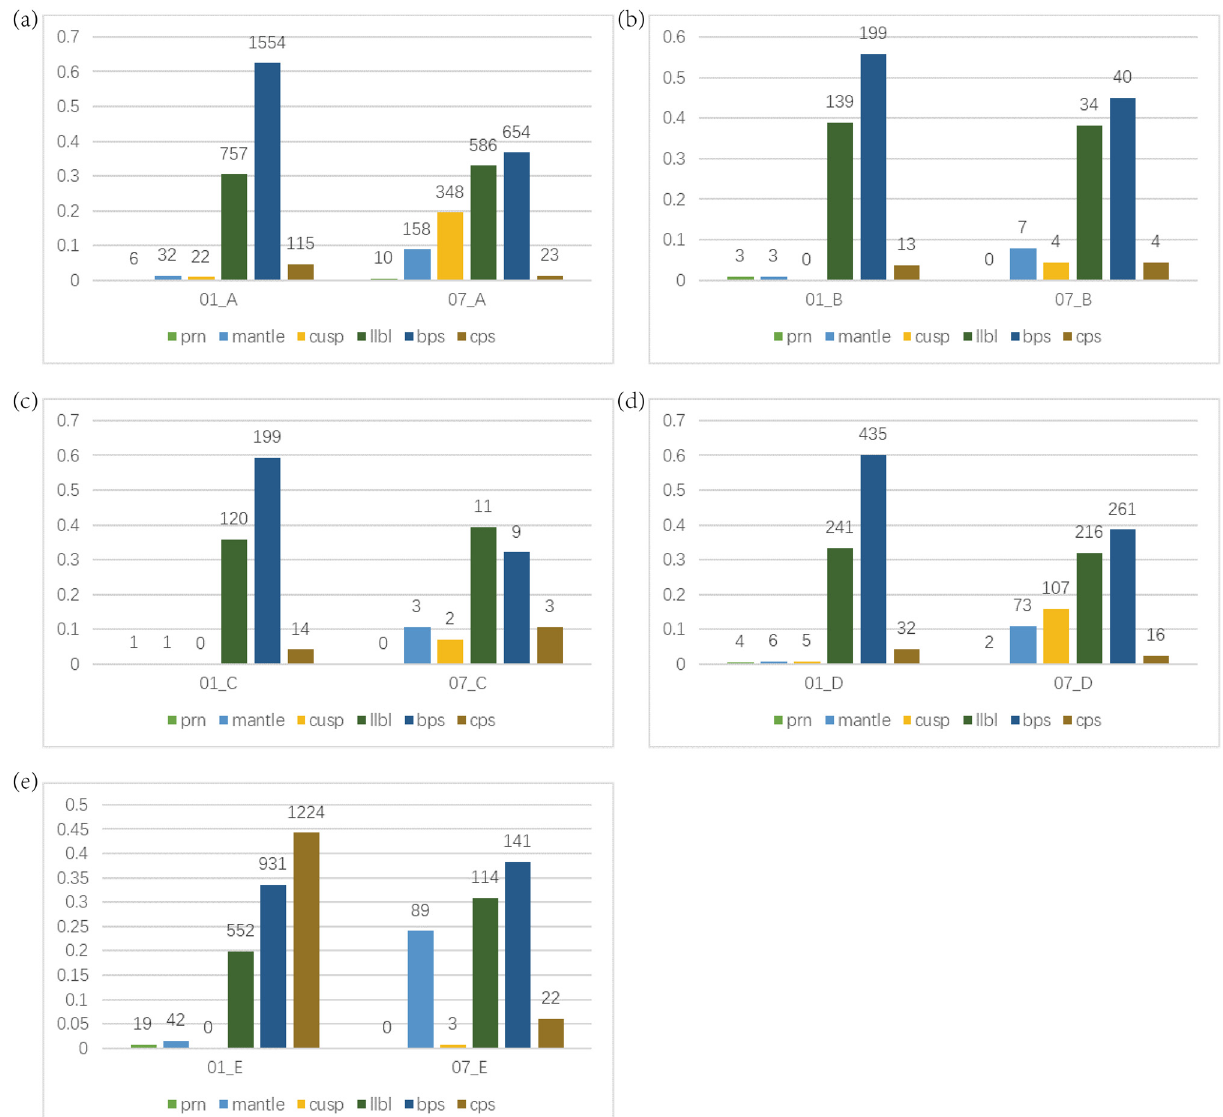
Figure 2. The distribution of ion upflow events corresponding to different magnetospheric source regions. ( a – e ) indicates type A–E ion upflows, respectively. ( left ) Statistics for January; ( right ) statistics for July. Table 1. Statistics of ion upflows in the geomagnetic latitude range of 70–80° on the dayside region of northern hemisphere in January and July 2005. From left to right, the source region of the mag ‐ netosphere is, successively, polar rain (prn), plasma mantle (mantle), polar gap (Cusp), low ‐ latitude boundary layer (LLBL), plasma sheet boundary layer (BPS) and central plasma sheet (CPS), the same below, while the others are the events with no clear magnetospheric source region, and sum is the total number.